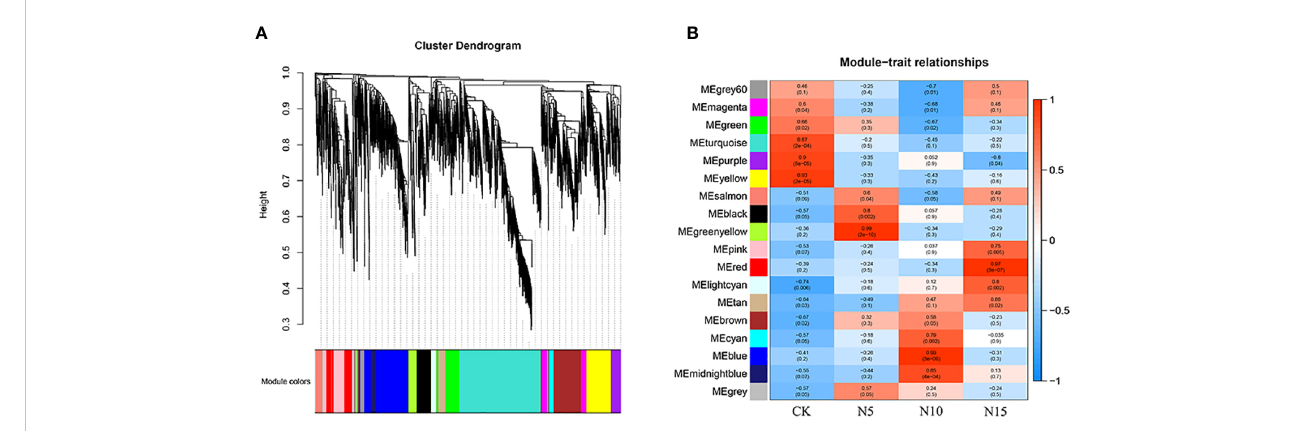
FIGURE 6 The analysis of WGCNA. (A) The collected genes were clustered and merged into different modules. (B) Module – trait associations. Each cell contains the corresponding correlation and p-value. The color bar indicates the correlation of each module with each